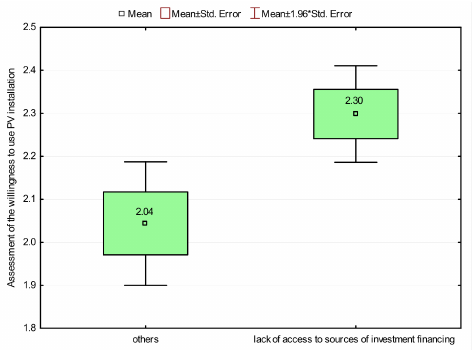
Figure 15. What is the biggest barrier to decarbonization in transport (lack of access to finance for investment) vs. assessment of the willingness to use PV